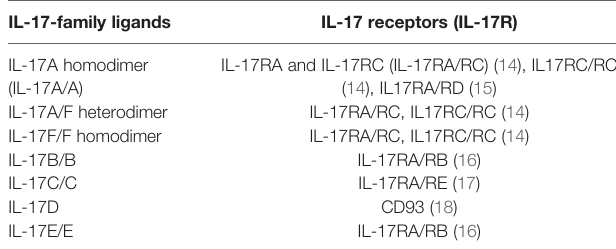
TABLE 1 | The IL-17 family and its